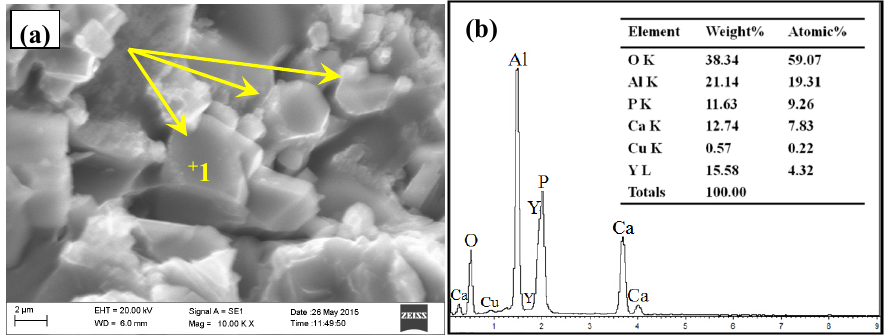
Figure 6. FESEM micrograph and EDS analysis of Y-rich phase in Al–2Ca–3Y–1P alloys: ( a ) microstructure; ( b ) EDS analysis for spot 1 in ( a ).